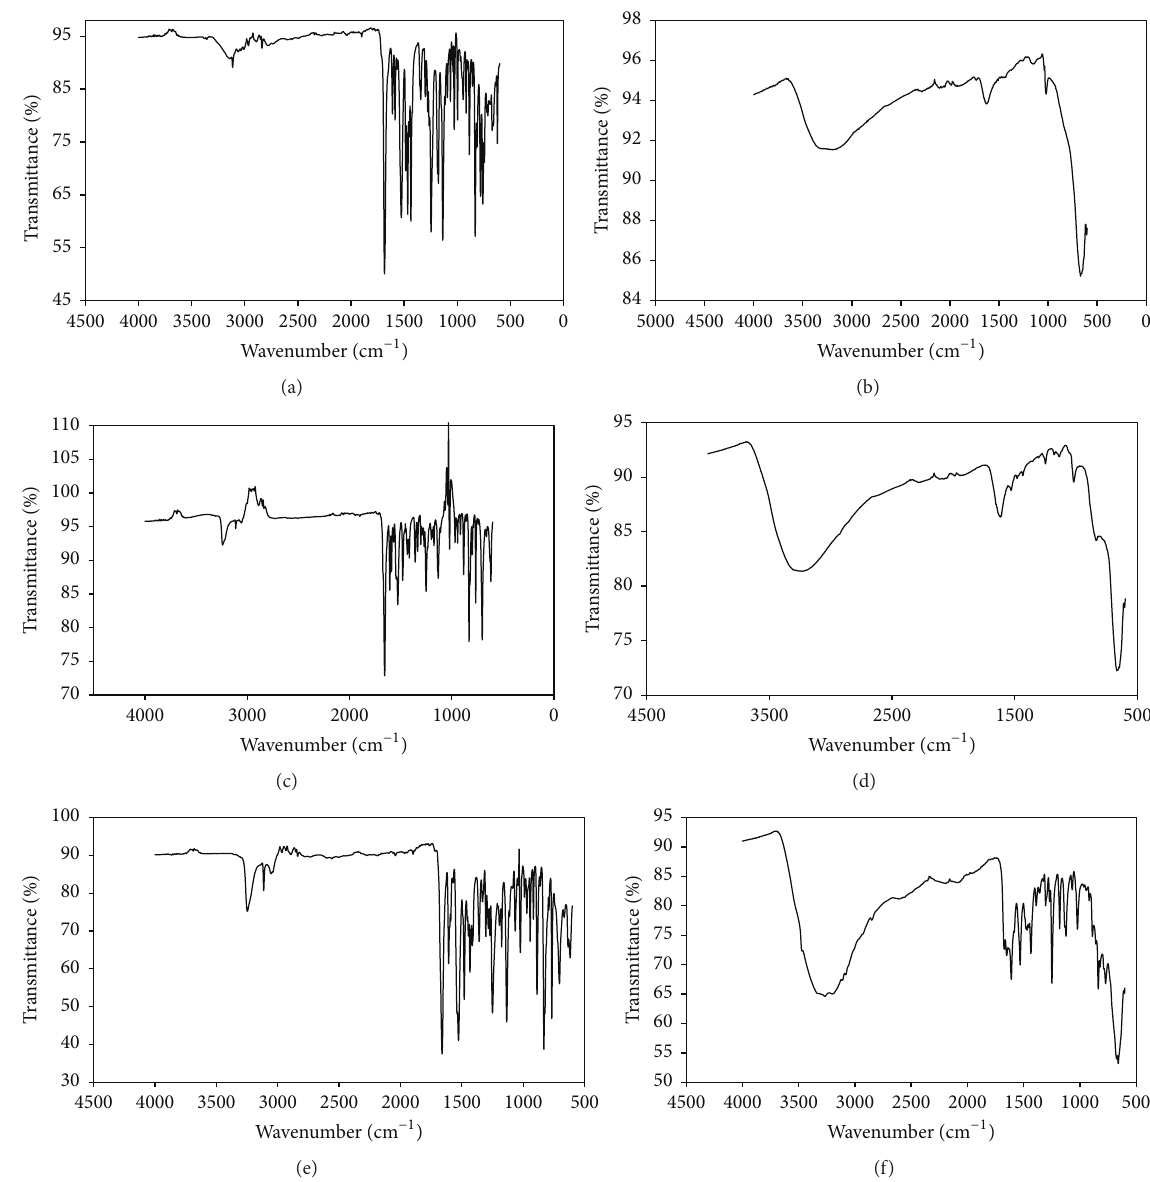
Figure 12: FITR spectra of (a) pure 2-MTPH, (b) scratched MS surface adsorbed 2-MTPH film, (c) pure 3-MTPH, (d) scratched MS surface adsorbed 3-MTPH film, (e) pure 4-MTPH, and (f) scratched MS surface adsorbed